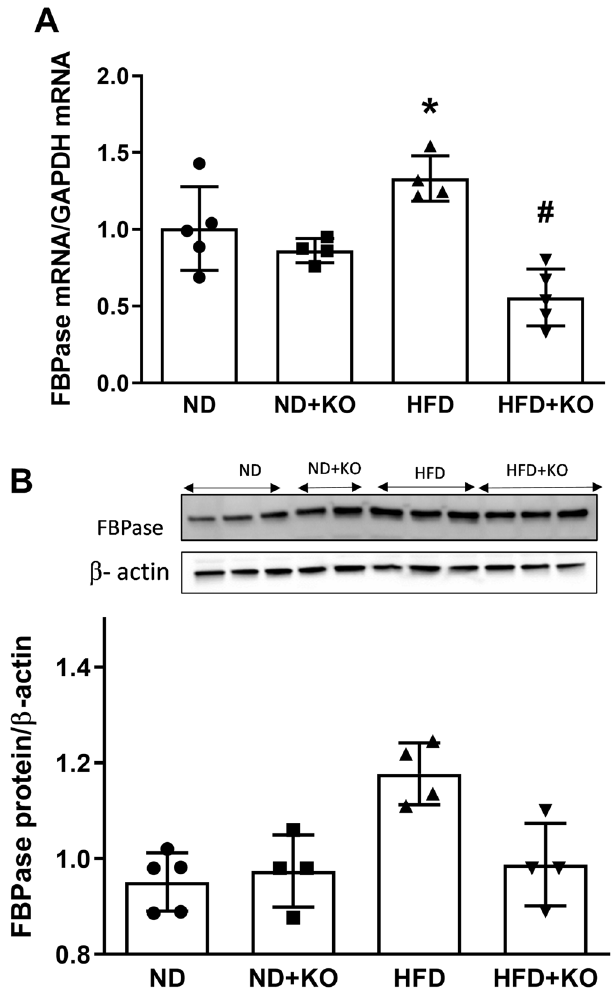
Figure 6. Renal cortical expression of FBPase. Renal cortical mRNA and protein expression of FBPase after 8 weeks following normal diet (ND) and high fat diet (HFD) in mice with or without Atp6ap2-KO. Data presented as mean ± SEM. * P < 0.05 versus HFD; # P < 0.05 versus HFD + KO, n = 4–5 each